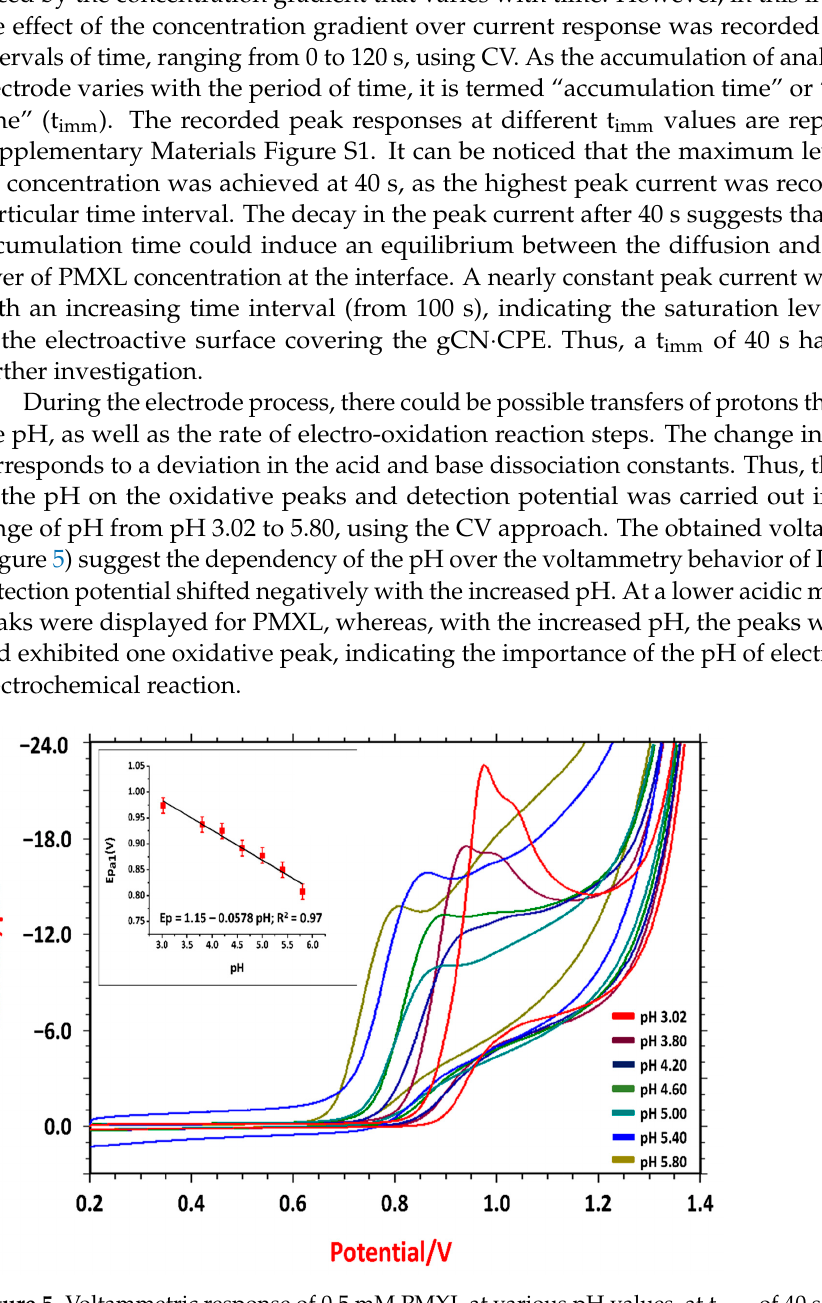
Figure 5. Voltammetric response of 0.5 mM PMXL at various pH values, at t imm of 40 s; (a) dependency of peak potential on pH of PBS.